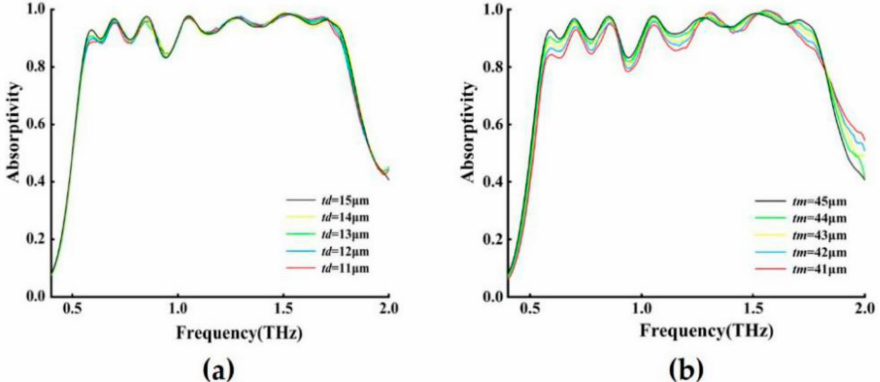
Figure 7. Absorbance of structures with different thicknesses. ( a ) Single-layer dielectric when Q = 100 µ m, and t m = 45 µ m ( b ) Double-layer dielectric thickness when Q = 100 µ m, and t d = 12 µ